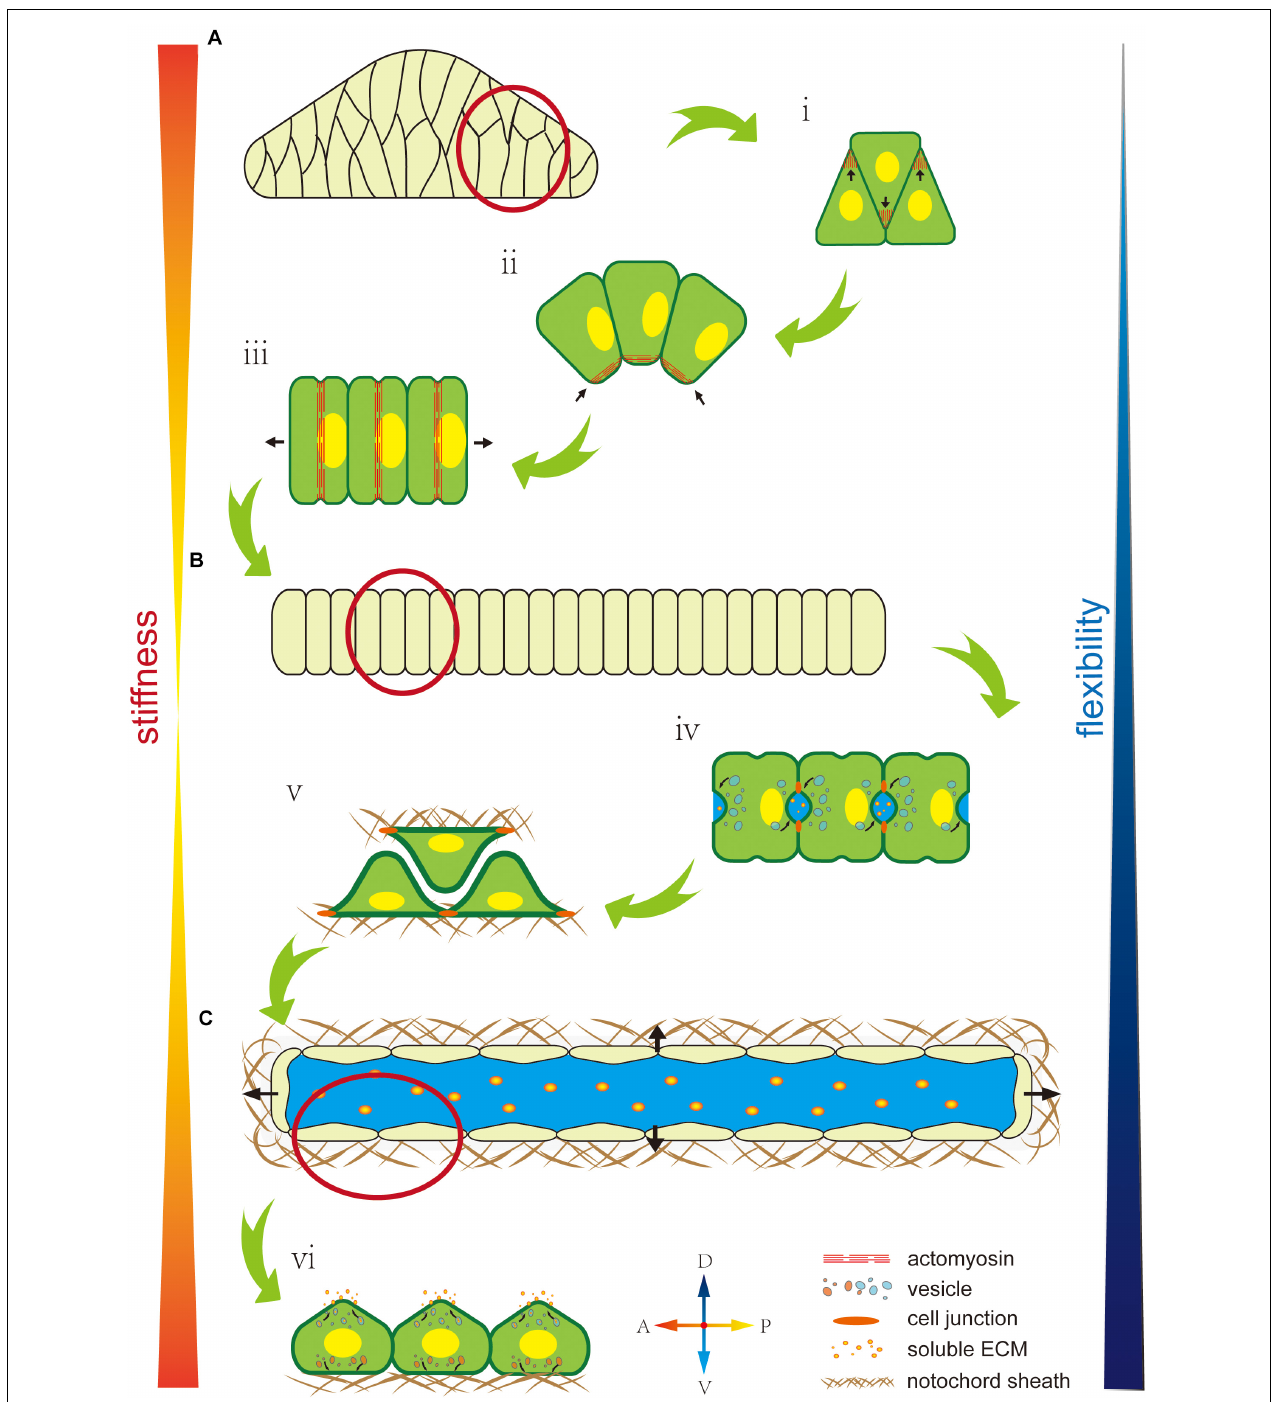
FIGURE 3 | Mechanical properties of the notochord are regulated by cell polarity. (A) The early notochord is a short, thick, stiff, rod-like structure made up of a multiline of cells. (i) Polarized F-actin drives cells to migrate and intercalate to form a single line. (ii) Ventrally polarized actomyosin drives notochord bending toward the ventral side. (iii) An equator-localized contractile ring drives notochord cell elongation. (B) The notochord forms as a long, thin, single cell-line cord. Its stiffness is low but flexibility is high, which facilitates rapid embryonic development in the narrow space inside the chorion. (iv) AB polarity is built during extracellular lumen formation. (v) Notochord cells migrate bidirectionally along the notochord sheath. (vi) Notochord cells form an endothelial-like single layer. (C) A single lumen-filled notochord tube increases tissue stiffness and flexibility, which enables the swimming of Ciona larva in seawater.